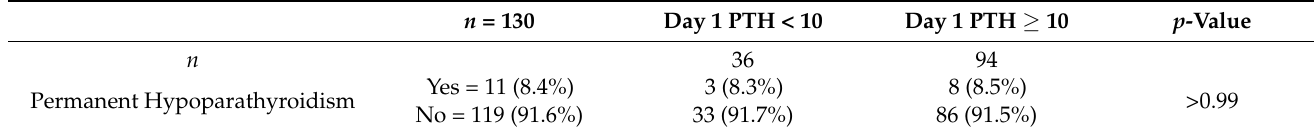
Table 3. Incidence of permanent hypoparathyroidism: day 1 PTH ≤ 10 pg/mL vs. day 1 PTH > 10